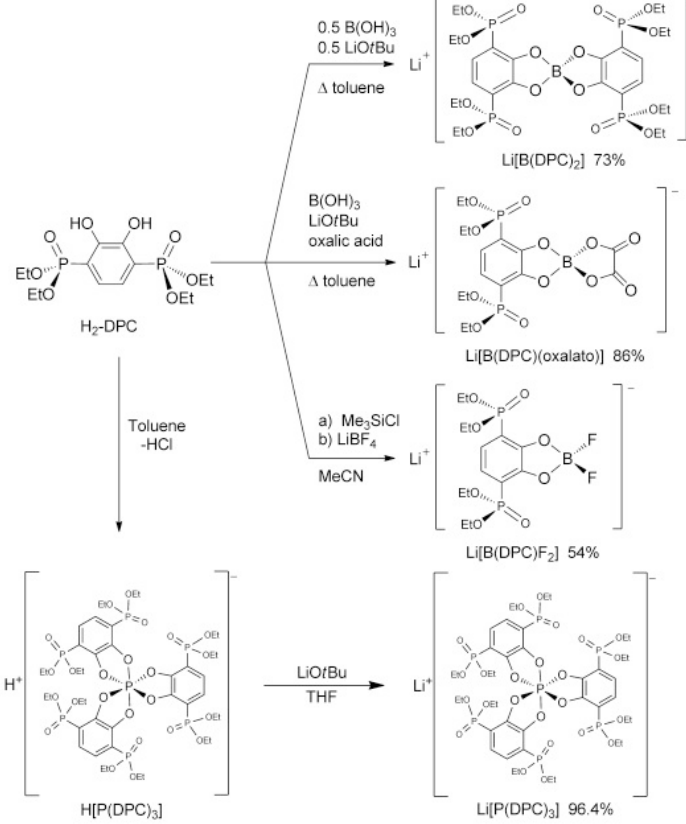
Figure 13. Conversion of 1,2-diphosphinatocatechol into phosphoryl-rich FR ions (FRIONs). Adopted from Ref. [215].